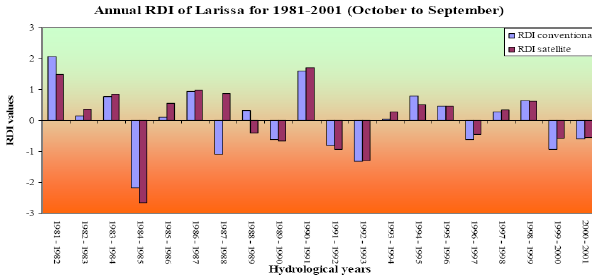
Fig. 3. Annual (October to September) RDI of Larissa for 1981–